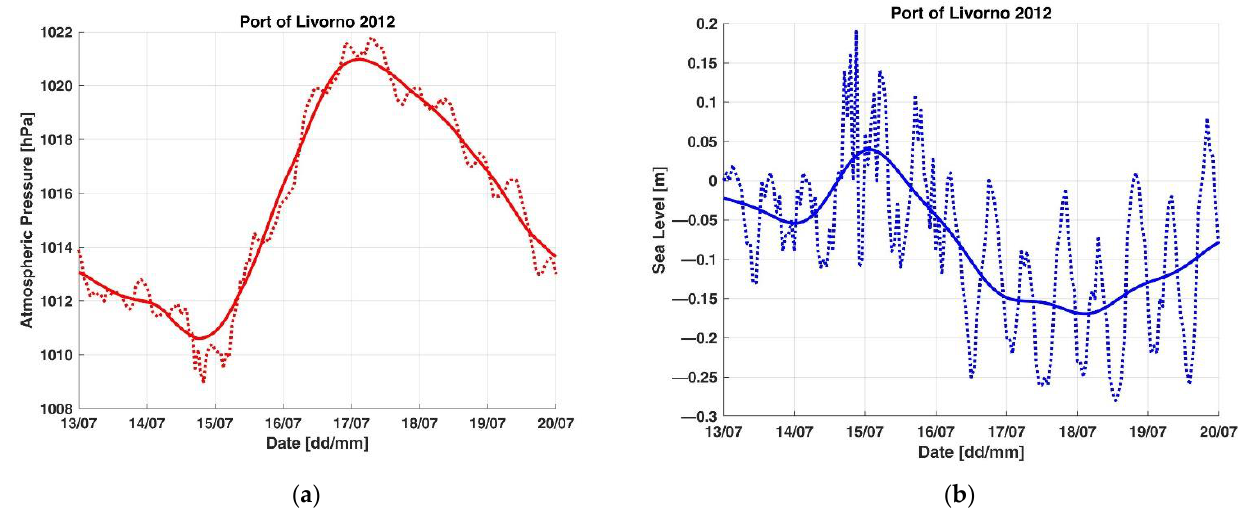
Figure A3. Low-frequency components of meteo-mareographic parameters acquired by ISPRA’s monitoring station in the port of Livorno from 13 to 20 July 2012 ( a ) atmospheric pressure; ( b ) sea level.